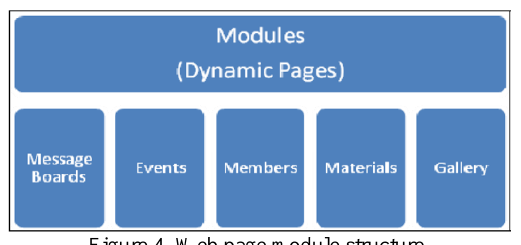
Figure 4. Web page module structure.